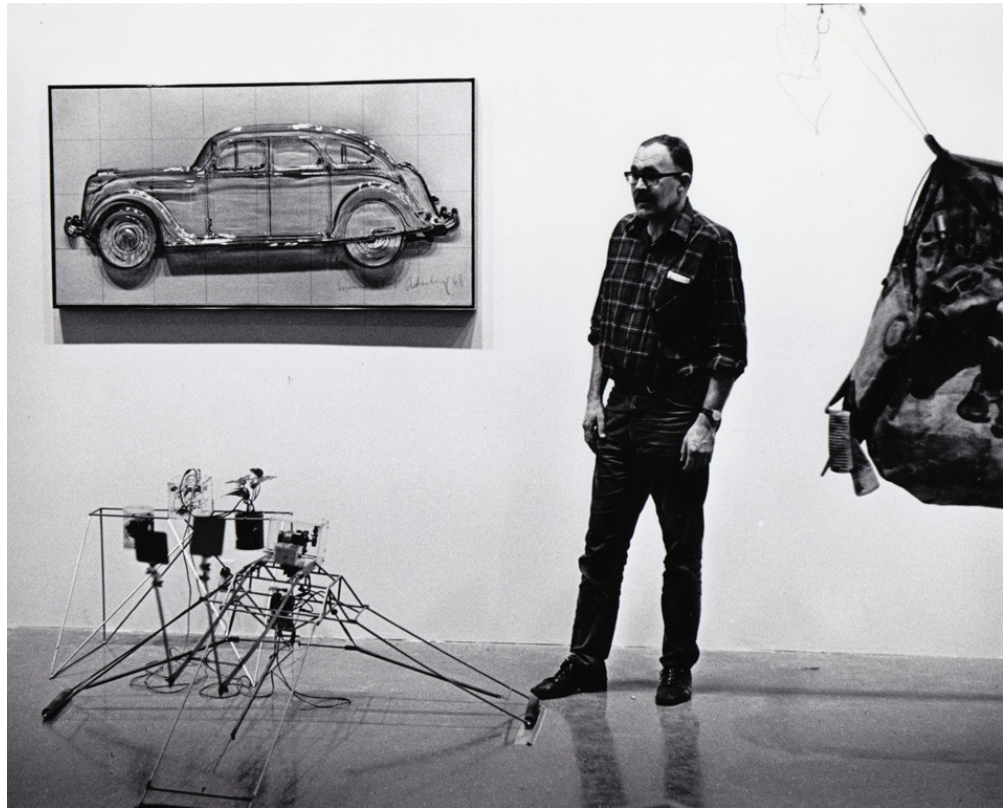
Figure 1. Pontus Hultén during the installation of the exhibition The Machine as Seen at the End of the Mechanical Age , Museum of Modern Art, New York, 1968. Around, works by Claes Oldenburg and Thomas Shannon. Photograph: Shunk-Kender © J. Paul Getty Trust. Getty Research Institute, Los Angeles (2014.R.20).